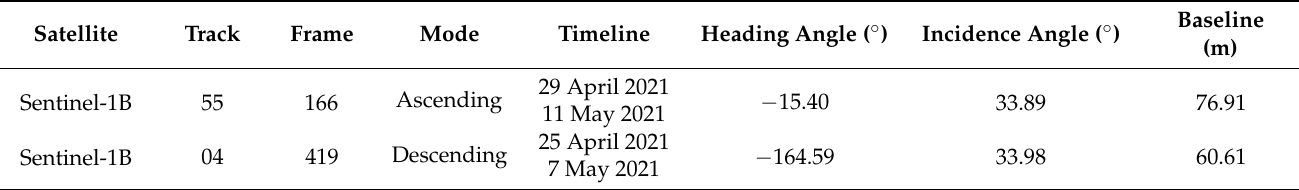
Table 5. Parameters of SAR images used for the 2021 Mw5.6